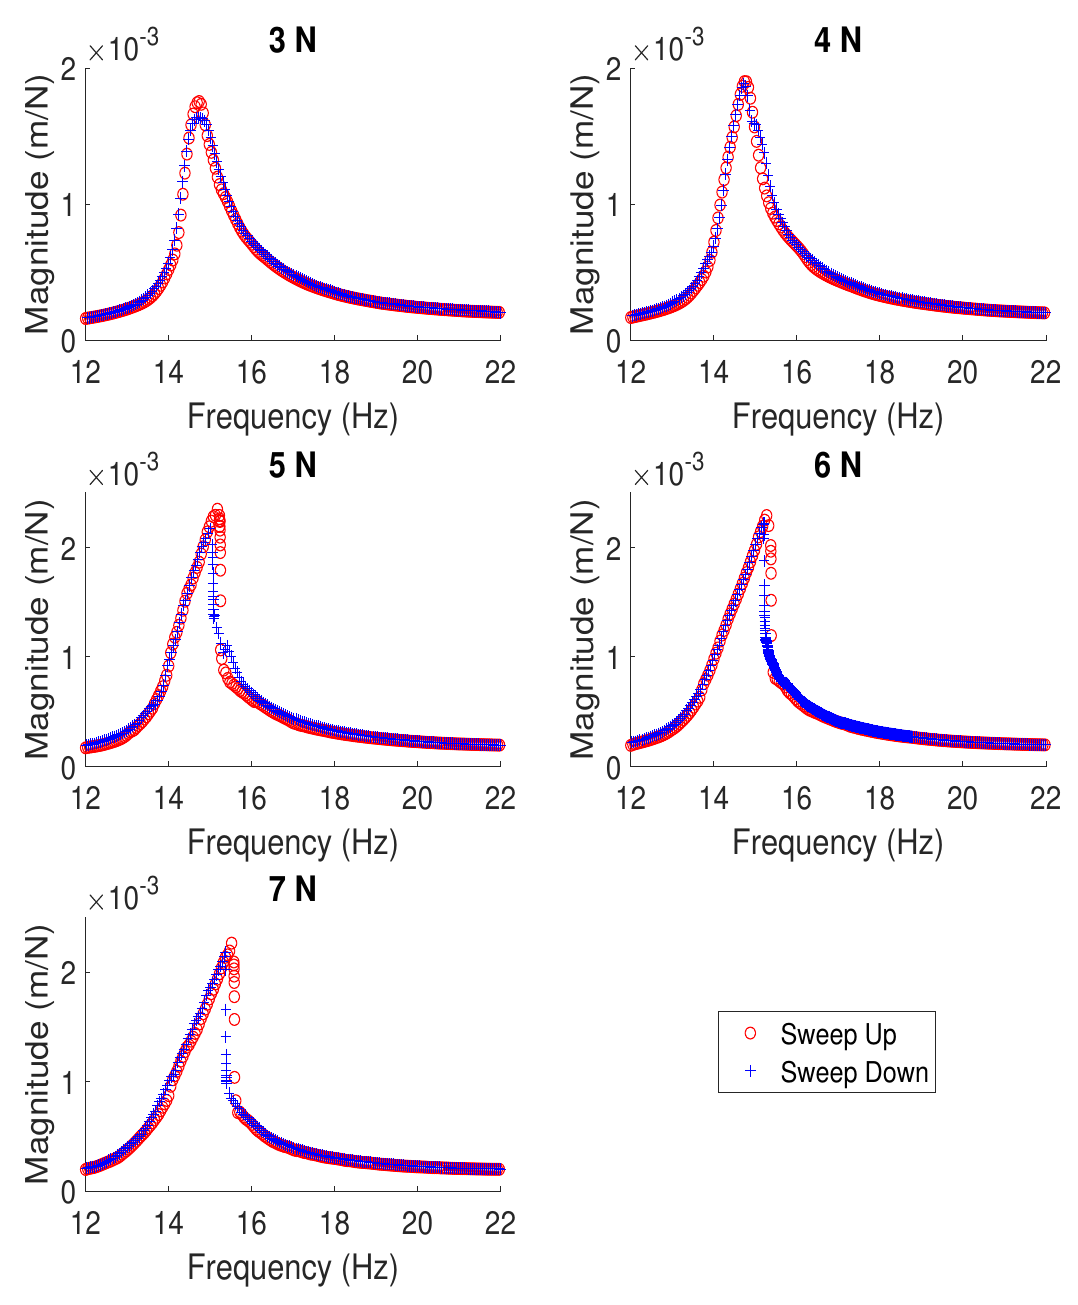
Figure 4. Results pertaining to the first resonance frequency of the structure for five different excitation force magnitudes, sweeping both up and down the frequency